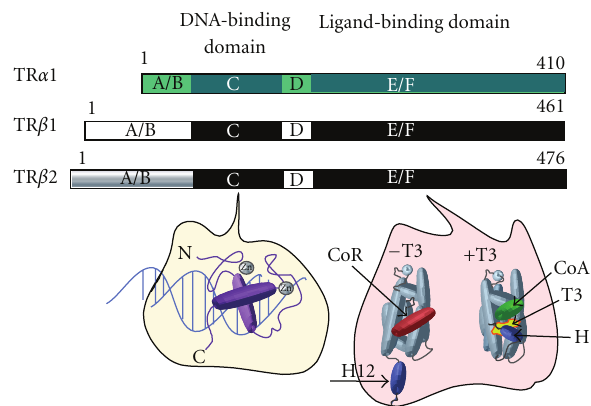
Figure 2: Domain comparison of di ff erent TR isoforms and schematic of DNA- and ligand-binding domain crystal structures. Each TR isoform is represented as a horizontal bar, from N to C termini. Total amino acid length is indicated at right [35, 36]. Within a given isoform,the location of each domainis lettered (A/B, C, D, and E/F). Identical domains of TR β 1 and TR β 2 are shown in matching colors. Note the unique A/B domain of TR β 2. Below left depicts the structure of the TR DNA-binding domain. α -helical domains are represented as purple cylinders and coordinating zinc atoms (Zn) as silver spheres. Below right depicts two conformations ( − T3 and +T3) of the TR ligand-binding domain, which is composed of 12 α helices; the 12th helix (dark blue cylinder, labeled “H12”) contains the ligand-dependent activation domain. In the − T3 conformation, helix 12 is in an extended position and the corepressor binding groove is filled with the CoRNR-box helical motifs found in SMRT and NCoR (red cylinder, labeled “CoR”). In the +T3 conformation, helix 12 has rotated to close around T3 hormone ligand (shown in yellow), and a novel docking surface for the LXXLL motifsof a transcriptionalcoactivator hasformed (green cylinder, labeled “CoA”).